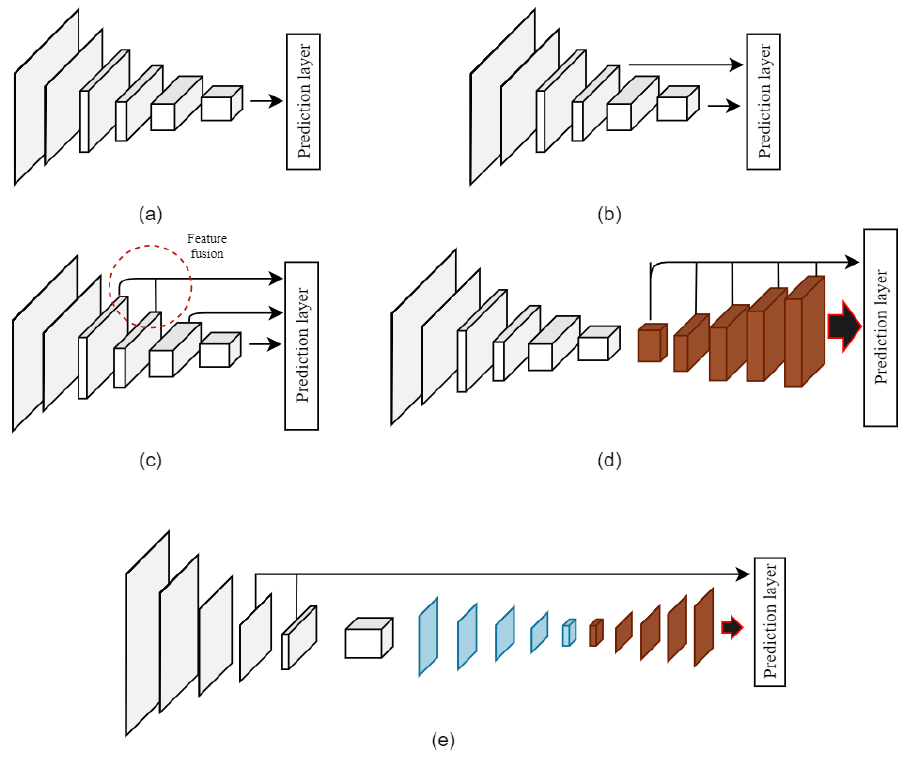
Figure 4. Schematic comparison of approaches used by different types of object